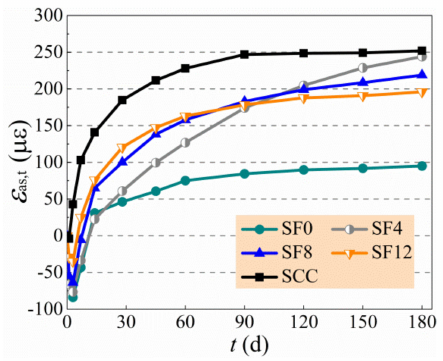
Figure 6. Autogenous shrinkage of tested specimens.